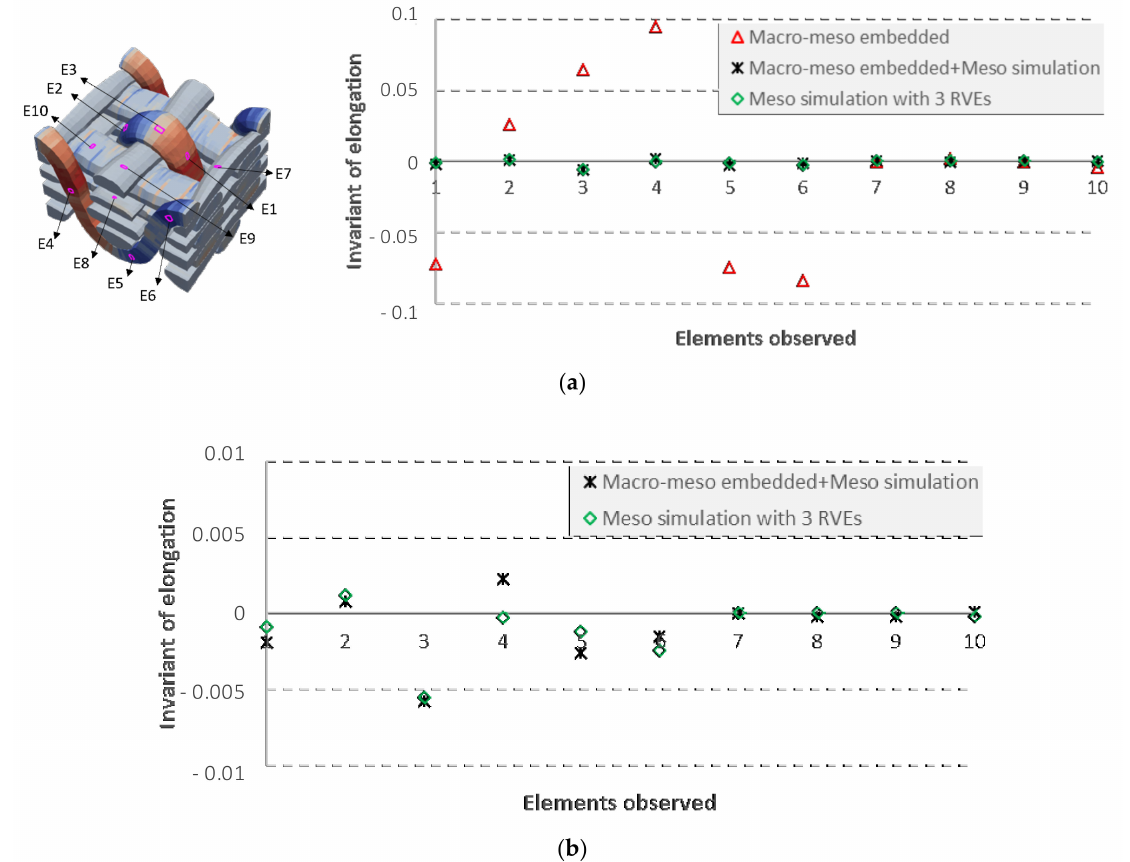
Figure 11. Comparisons of yarn elongation for ten elements in the same positions between the meso results of one RVE and threes RVEs: ( a ) with the result of Macro-Meso embedded approach, ( b ) without the result of Macro-Meso embedded